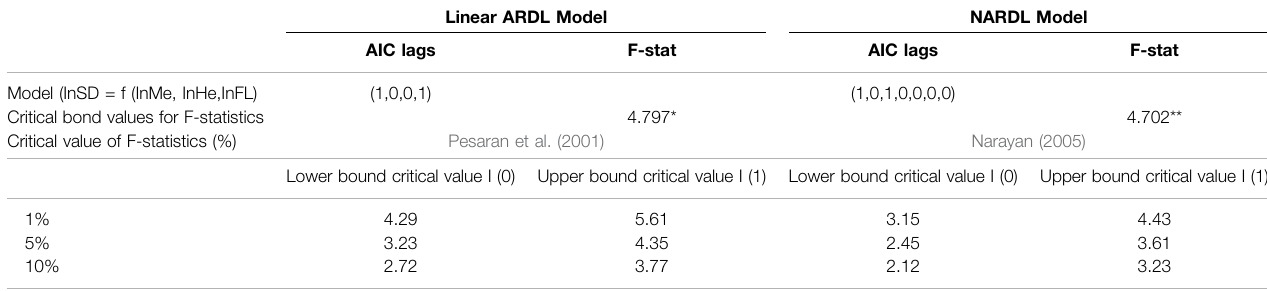
TABLE 4 | Cointegration bound test results for the baseline equation.